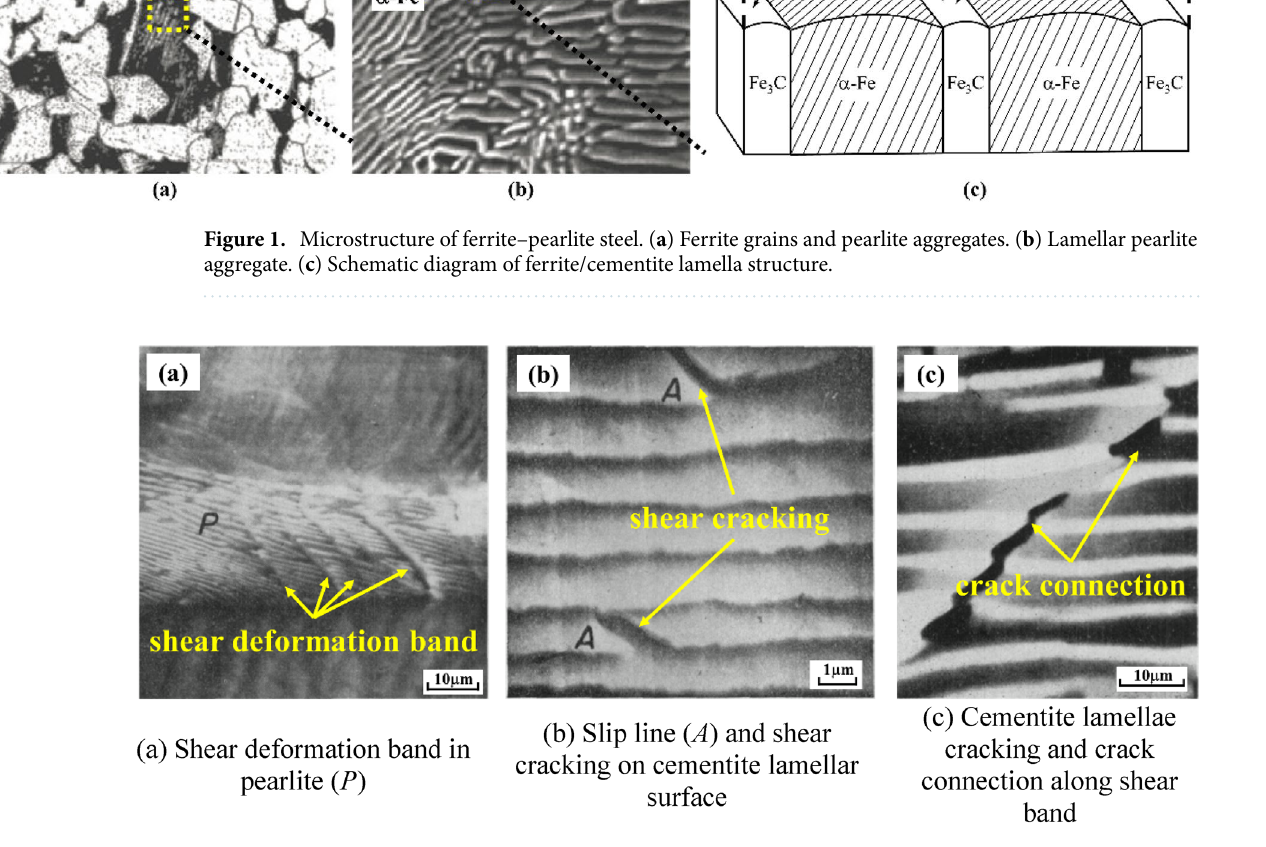
Figure 2. Deformation and crack initiation in pearlite 19